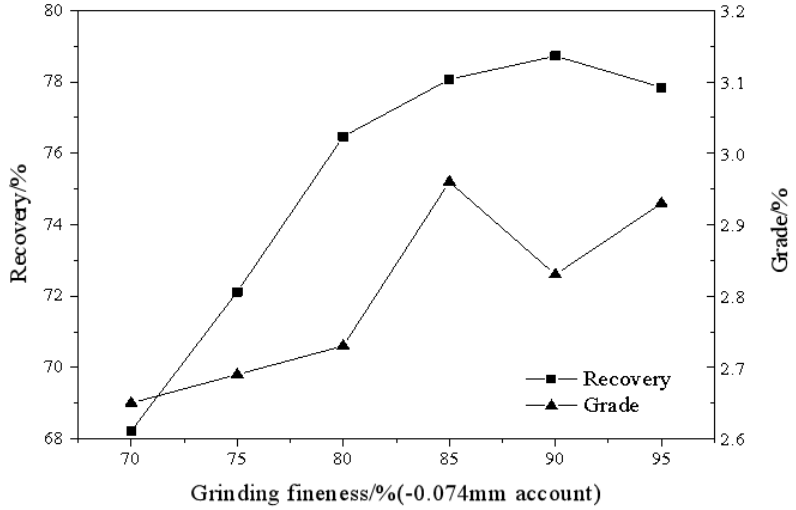
Figure 3. Influences of the grinding fineness of copper oxide flotation index.